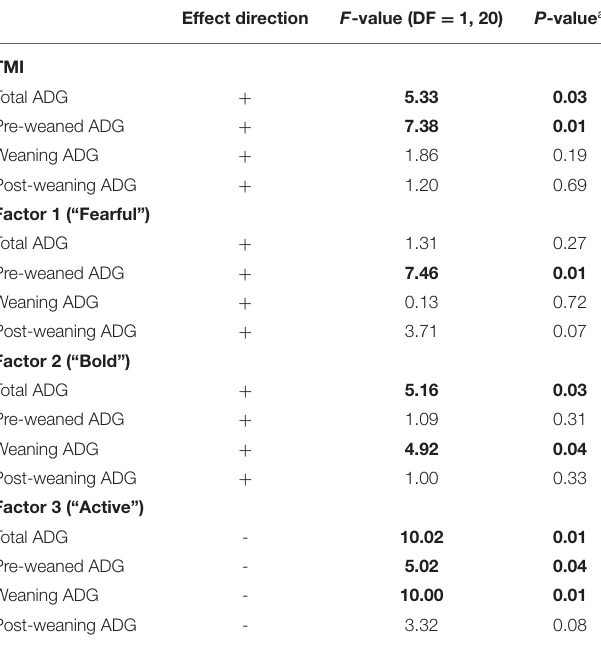
TABLE 5 | Relationship between ADG for each rearing period with total movement index (TMI) from the isolation box test and the factor scores extracted from the principal component analysis (containing behaviors from the standardized personality tests: novel person, novel object, and startle